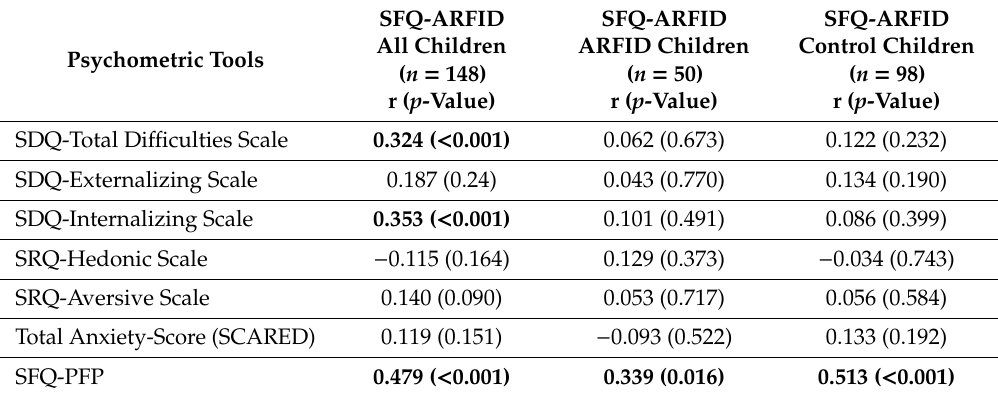
Table 5. Correlations between the different psychometric scales and the SFQ-ARFID Scale.